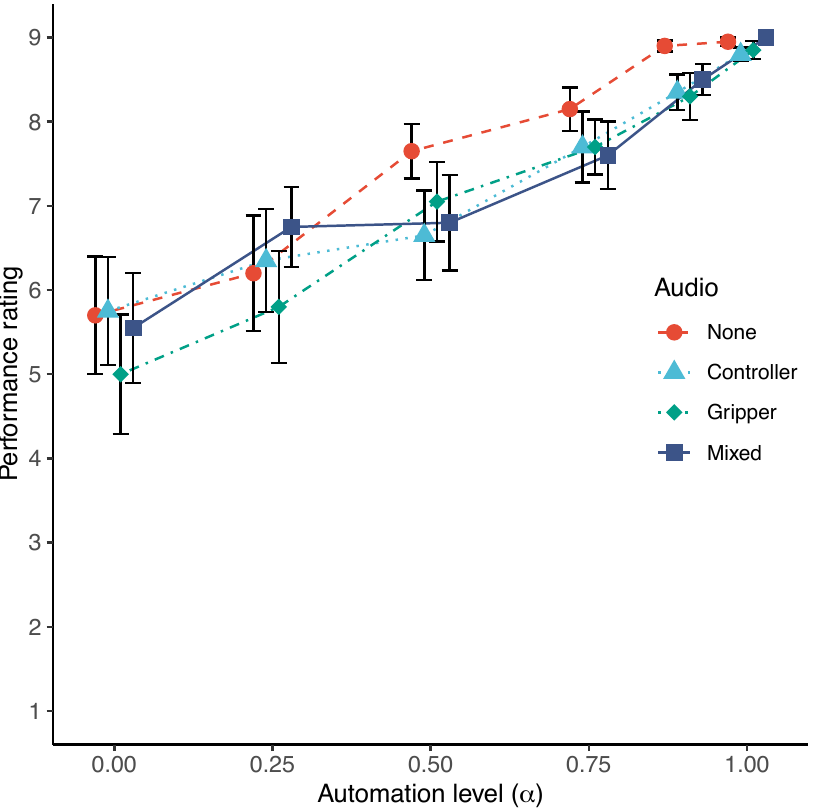
Figure 7. Mean performance ratings at each level of automation under four different auditory feed- back conditions. Error bars represent standard errors. Performance rating increases with increasing level of